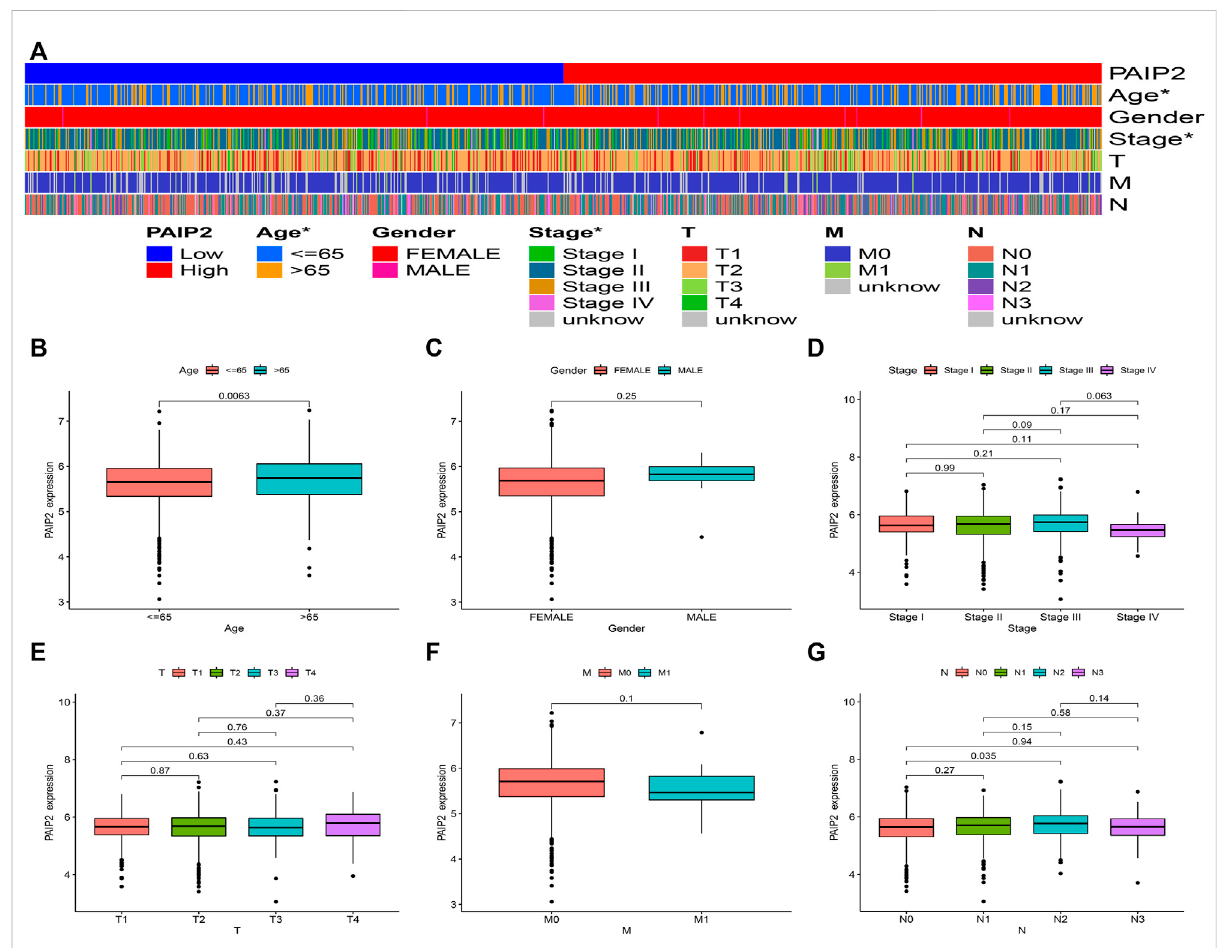
Correlation between PAIP2 expression and clinical features. (A) : The expression of PAIP2 was signi fi cantly correlated with age and stage. PAIP2 expression in different age (B) , gender (C) , stage (D) , stage T (E) , stage M stage (F) and N stage (G) .